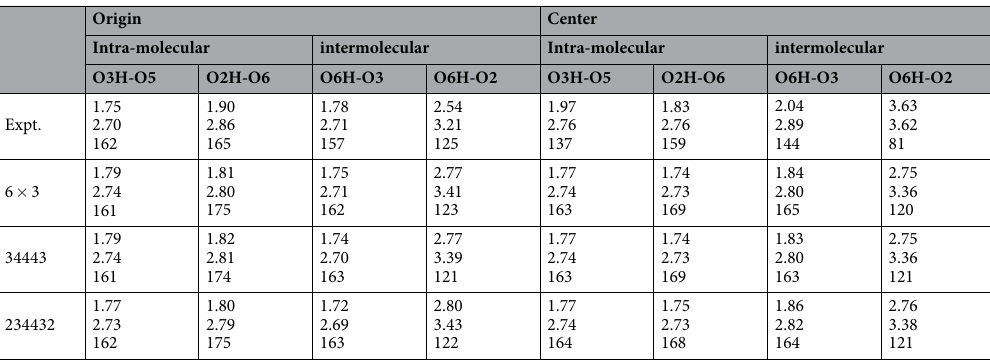
Table 1. H-bonding and selected O–O distances (Å) and H-bond angles (O-H-O in degrees) in 6 × 3, 234432 and 34443 models. Experiment values are from refs 1,2